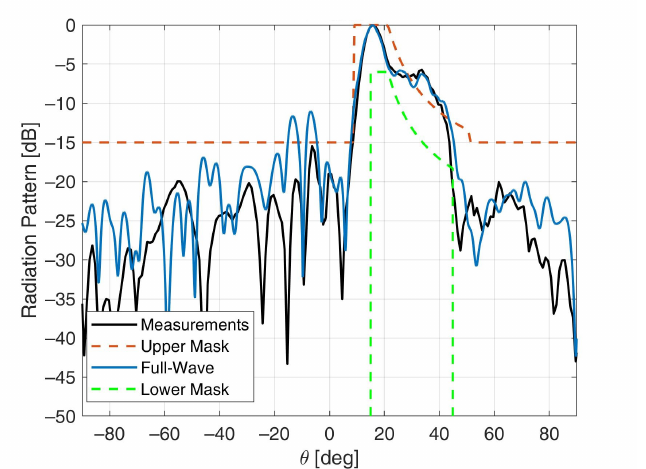
Figure 9. Radiation patterns in the E-plane at 29 GHz.